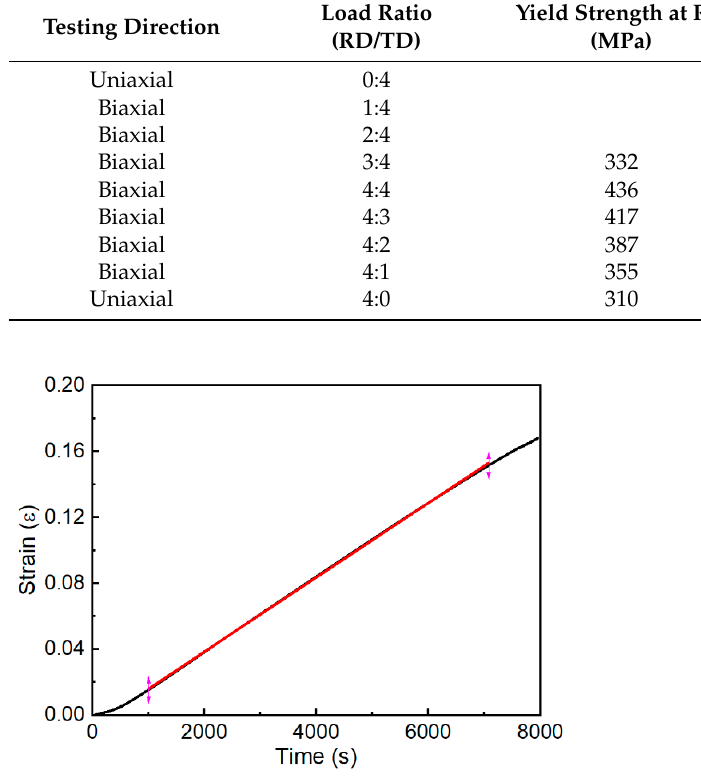
Figure 3. Schematic representation of the method to determined actual strain rate. Table 2. Uniaxial and biaxial tensile tests data at various strain rates.